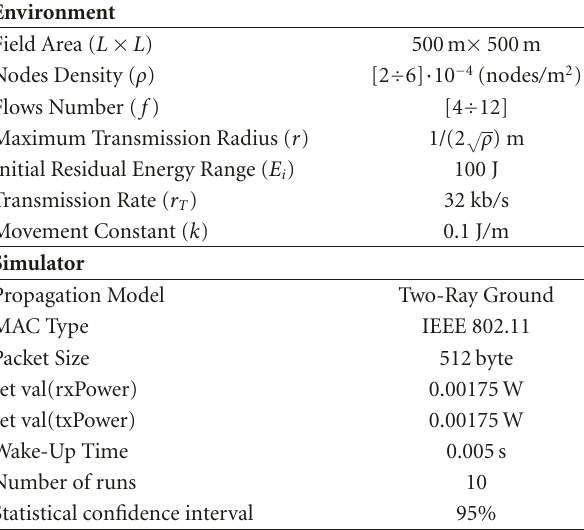
Table 1: Evaluation